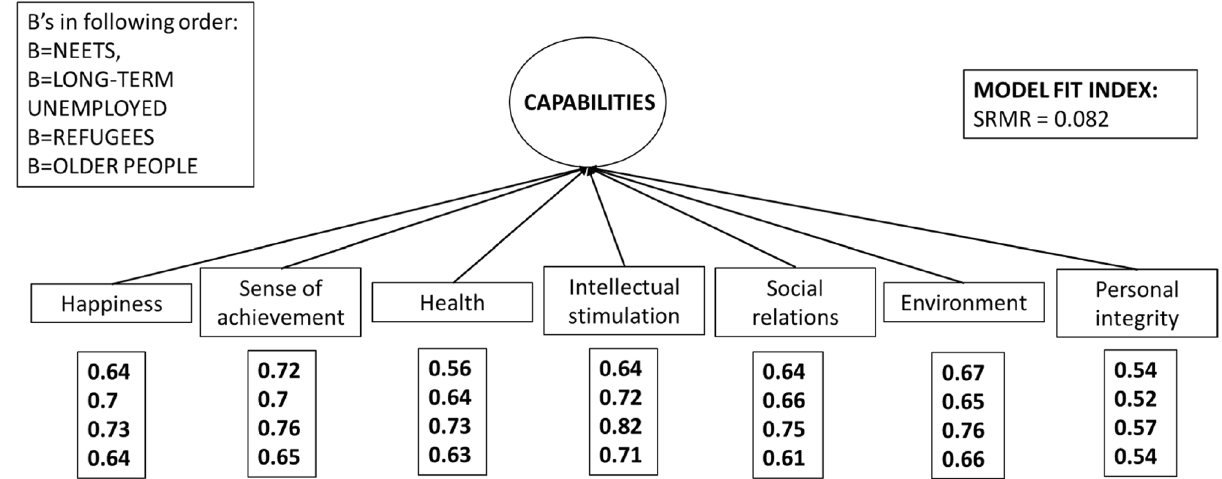
Figure 3. Measurement model for capabilities (latent variable) in the four study groups, standardized item loadings for the latent variable, and model fit index (SRMR), PROMEQ data (N =